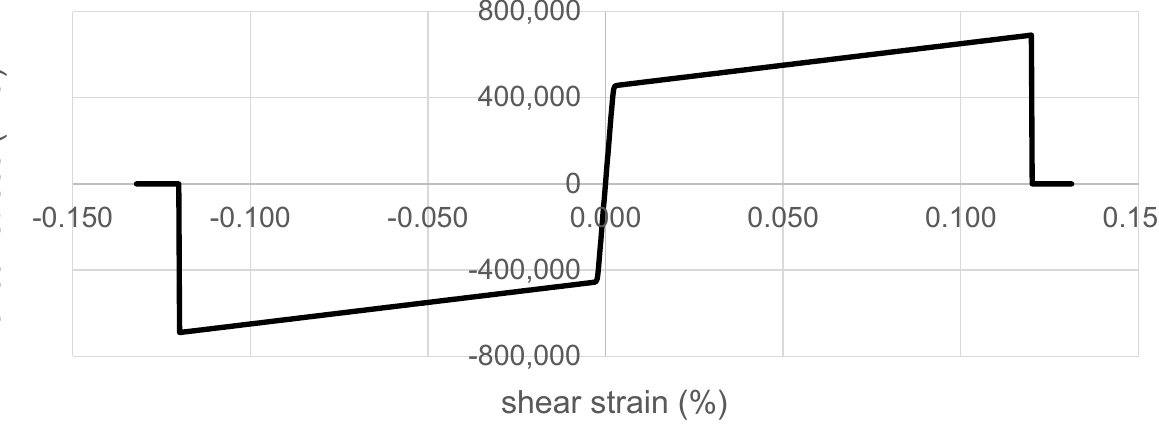
Figure 6. Shear stress vs. shear strain relationship for Steel02: Bars.